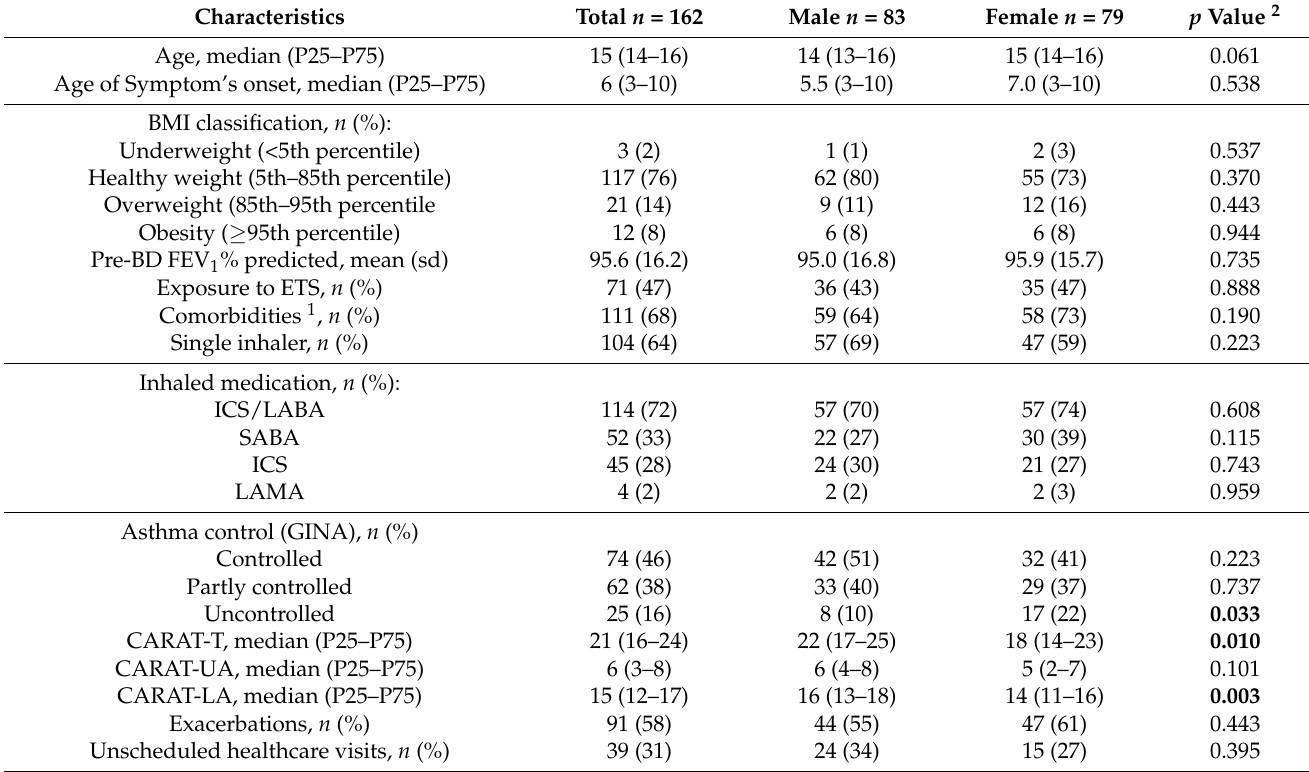
Table 1. Characteristics of adolescents at the time of enrolment (T0), according to sex ( n = 162).